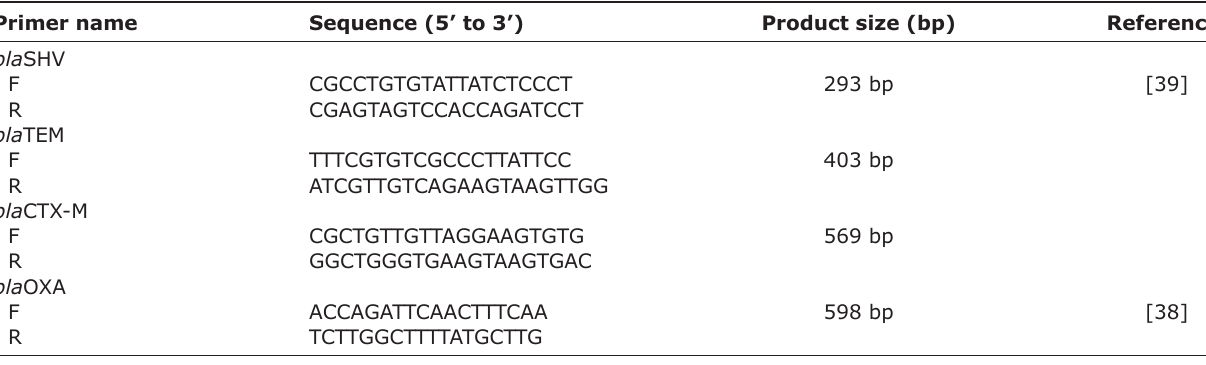
Table-2: Sequence of the oligonucleotide primers used for the detection of extended-spectrum beta-lactamase